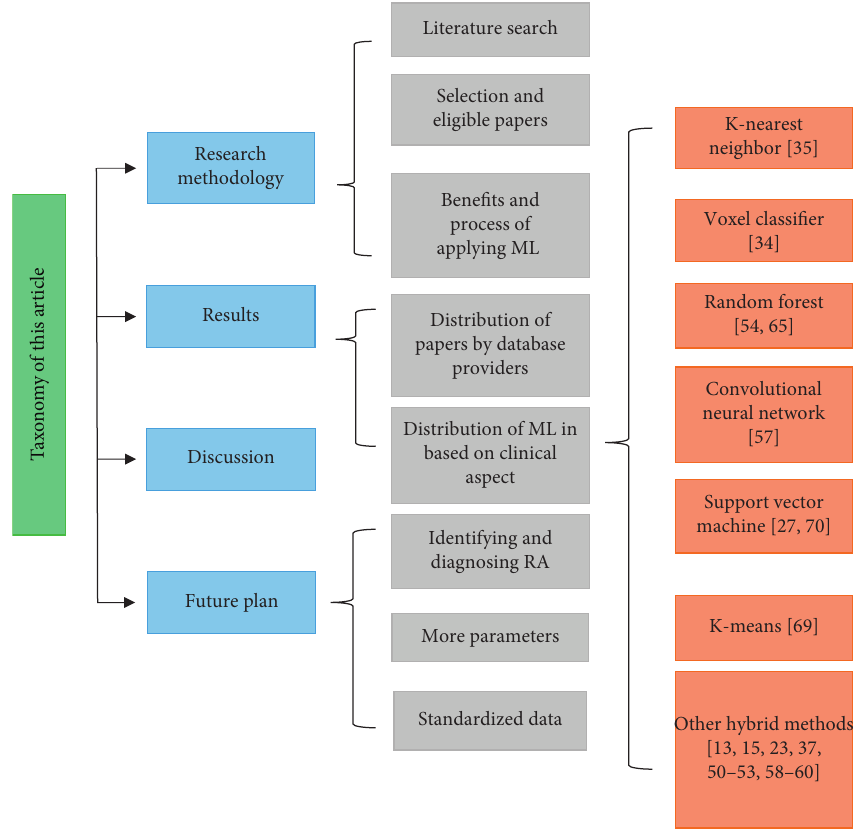
Figure 4: Taxonomy used in this article.